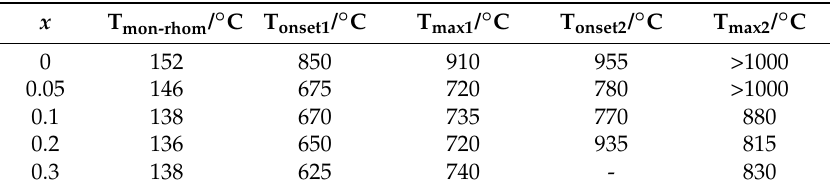
Figure 3. The first derivatives of the dilatometry curves during heating for identification of the phase transition ( a ) And characteristic temperatures related to high-temperature processes ( b ). Stars and arrows indicate the maximum slope changes and onset of phase segregation processes (new phase formation), respectively. Table 2. Onset temperatures and maxima of slope changes deduced from Figure 3a,b. The values of the high-temperature processes have an error of about ± 20 °C.